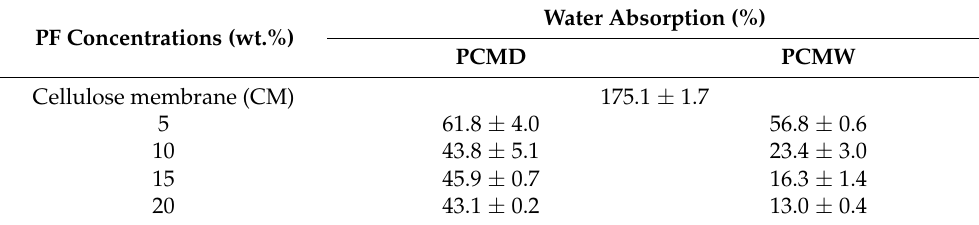
Table 2. Water absorption of phenolic cellulose membrane (PCM)